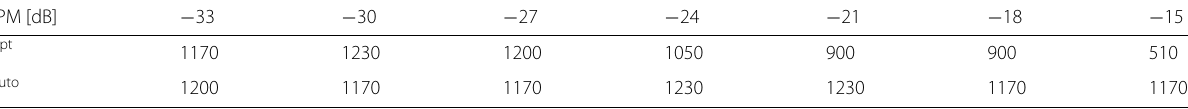
Table 7 Intrusively and non-intrusively determined reshaping filter lengths for PMINT for acoustic system S 1 and all considered NPMs NPM [dB]